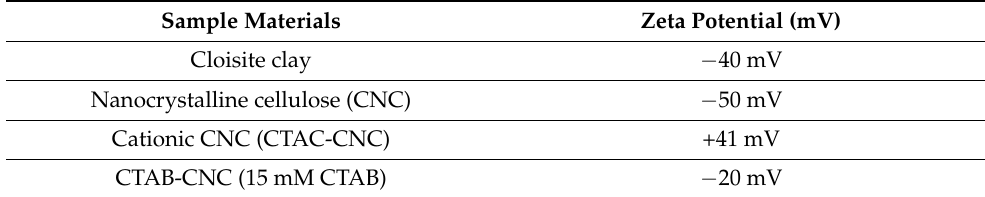
Table 1. Zeta potential of CNC and clay.